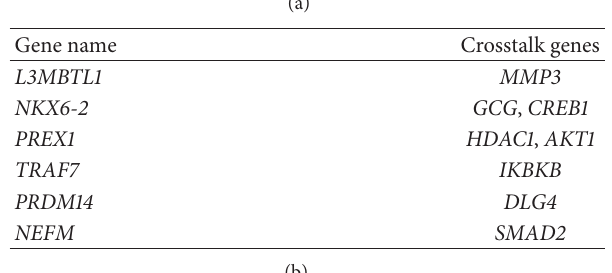
Table 3: Number of methylated CpG sites at promoter of identified genes.